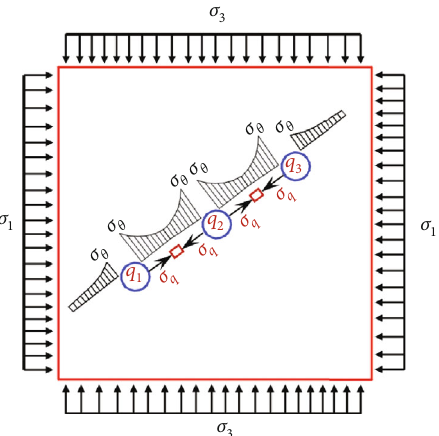
Figure 10: Distribution of tangential stress of multihole linear codirectional hydraulic